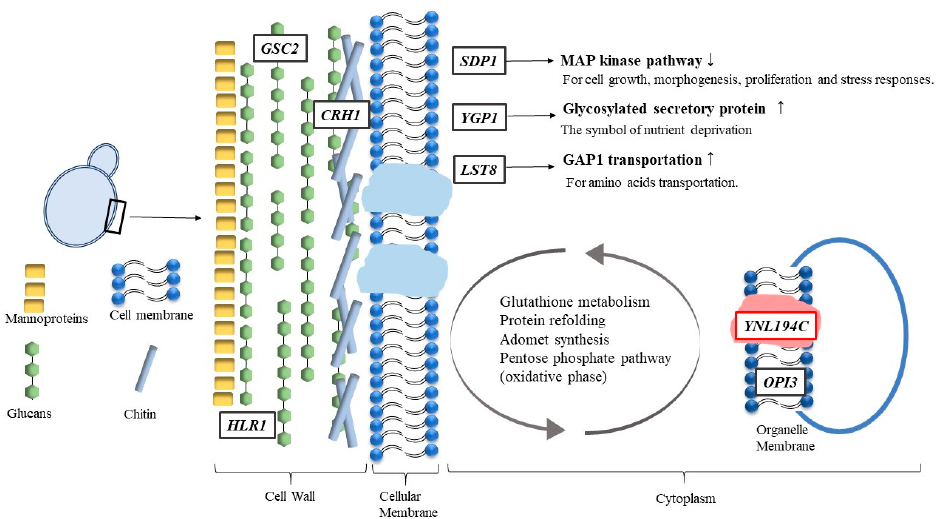
Figure 6. The sketch of the possible cell lethal mechanisms caused by HPCD on the met- abolic